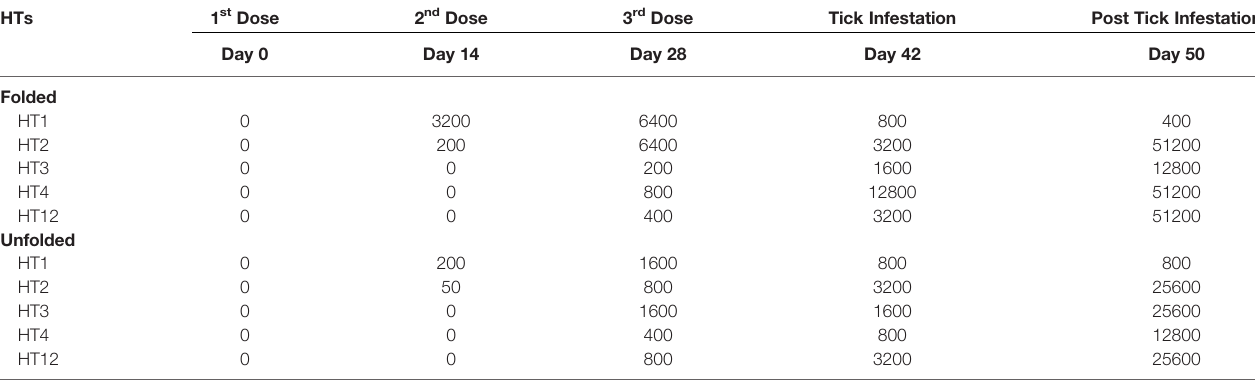
TABLE 1 | IgG titers from dog Trial 1 with individual dogs immunized with Folded and Unfolded HT formulations consisting of HT1, HT2, HT3, HT4 and HT12. HTs 1 st